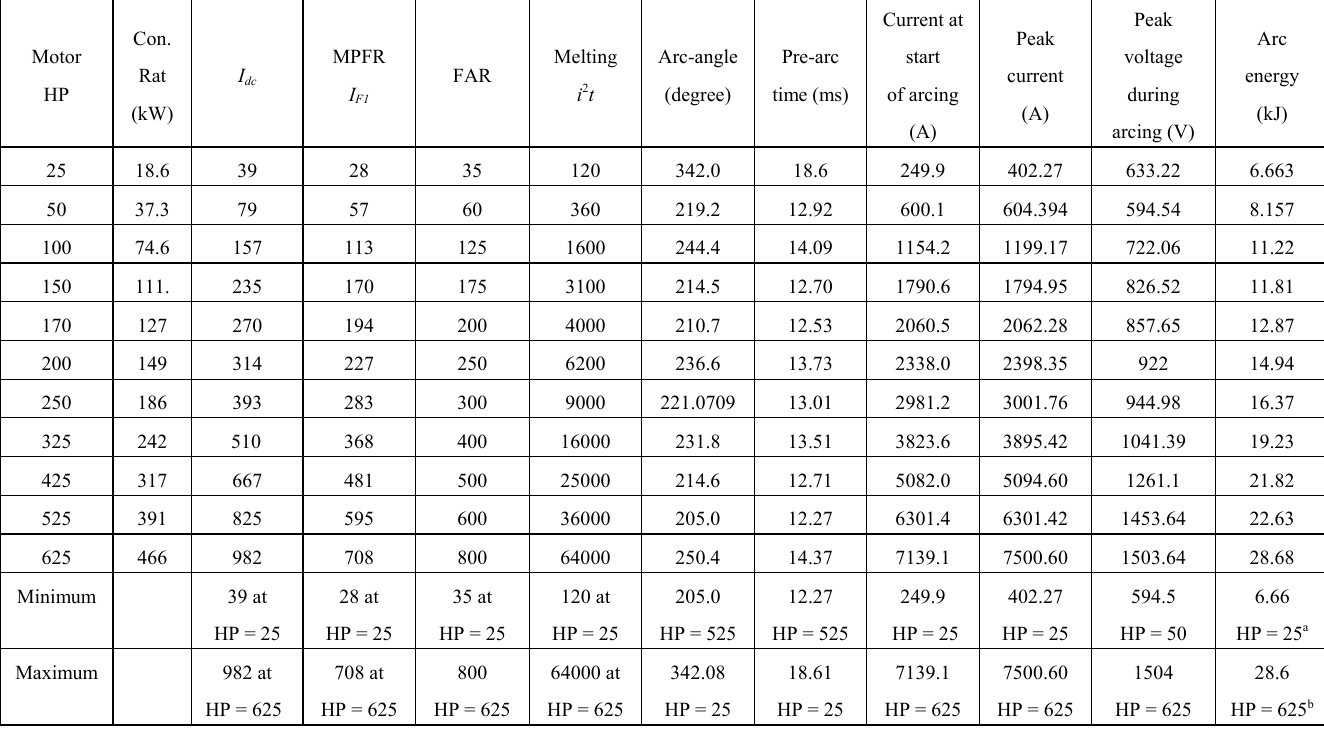
Table 5. Summary of the simulation